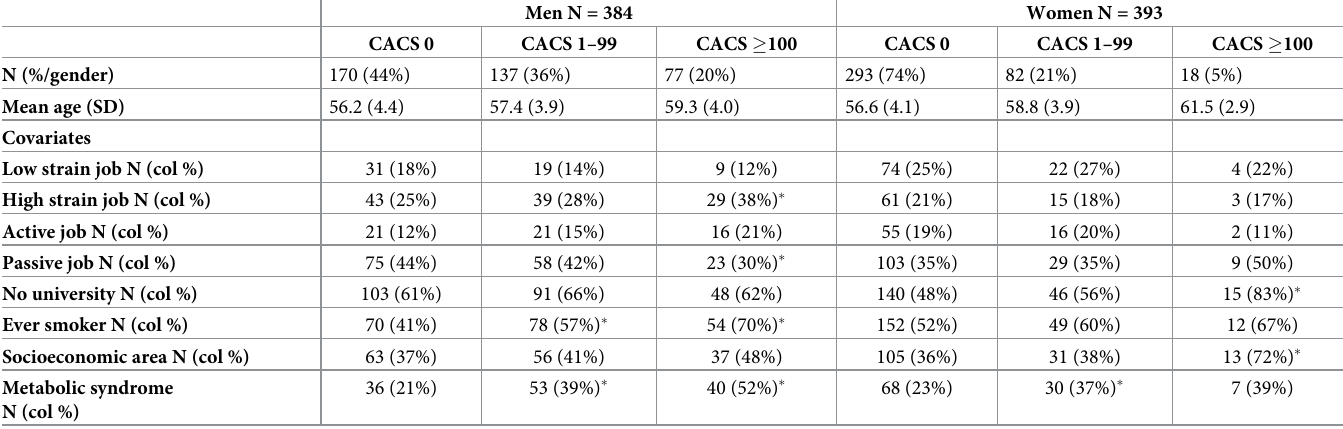
Table 1. Characteristics of subjects by gender and coronary calcium score